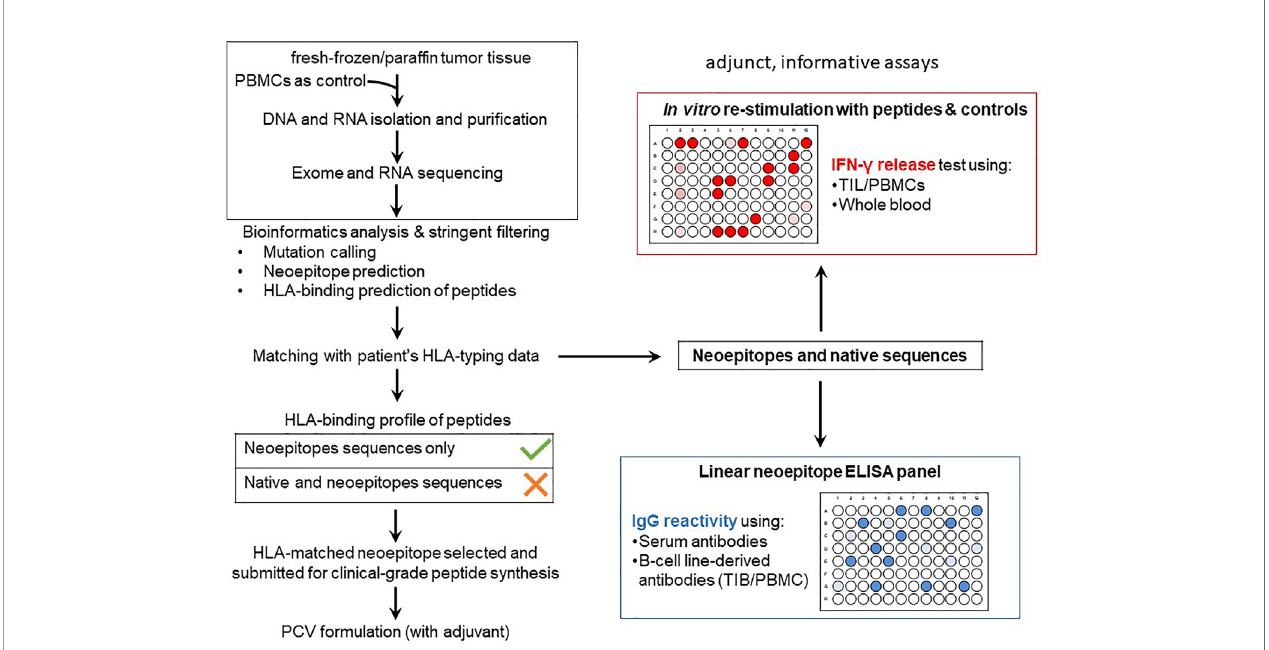
FIGURE 5 | PCV development and immuno-analyses work fl ow at the ImmunoSurgery Unit. Formalin- fi xed paraf fi n-embedded (FFPE) or fresh-frozen tissue samples prepared by the Pathology Unit at the CCC is submitted for WES of tumor DNA with the patient ’ s PBMCs as an internal control for downstream analysis, RNA-Seq is also sometimes performed to tumor RNA. The WES and RNA-Seq raw data is then analyzed at the ImmunoSurgery Unit at the CCU to predict private mutations followed by HLA class I and II binding prediction matched to the patients ’ HLA restriction pro fi le to select candidates for inclusion in the PCV formulation. Only HLA- binding, neoepitope-containing peptides but not the wildtype counterparts are considered. The same and also 15-mer equivalent but non-clinical grade peptides, alongside the corresponding native sequences, are used for gauging TIL and/or PBMCs reactivities based on IFN- g production (the peptide is at a concentration 1ug/mL tested with 10e 4 responder T-cells; the fi xed T-cell number allows to compare results obtained at different timepoints or from tissues harvested from different tumor areas). This part of the immunological evaluation of the neoepitopes is used in the follow-up phase of the trial which aims to assess T-cell responses of patients to the PCV and TIL therapies (possibly also for patients receiving immune checkpoint inhibitors). A different platform is an ELISA panel comprising the patient ’ s neoepitopes in linear format to assess IgG reactivity using antibodies from serum as well as those secreted by TIB and PBMC-derived B-cell lines. Neoepitopes are also screened for TIL recognition since TIL are routinely generated to gauge for differences in TIL versus PBMC recognition. This will allow to describe whether selected neoepitopes are recognized in the tumor lesion that was used to identify the tumor neoepitopes (by NGS), it also allows to screen for differences in TIL recognition from tumor lesions harvested at different anatomical sites or at different timepoints in the course of the